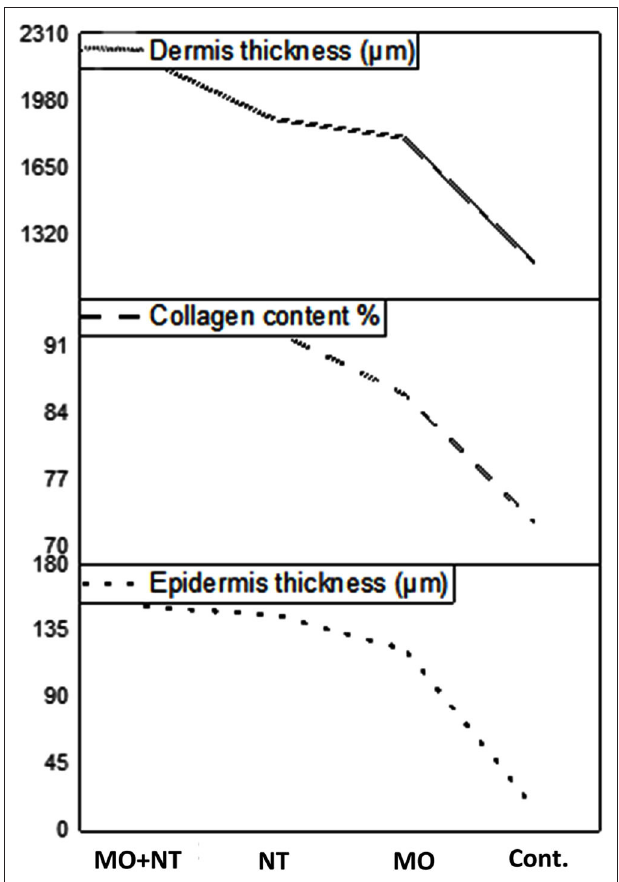
FIGURE 6 | Dermis, epidermis, and collagen analyses of different treatments.